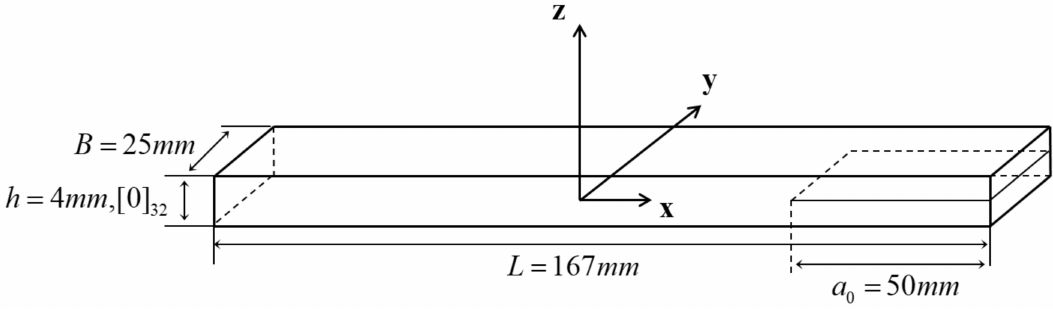
Figure 4. CFRP double cantilever beam (DCB) test specimen.